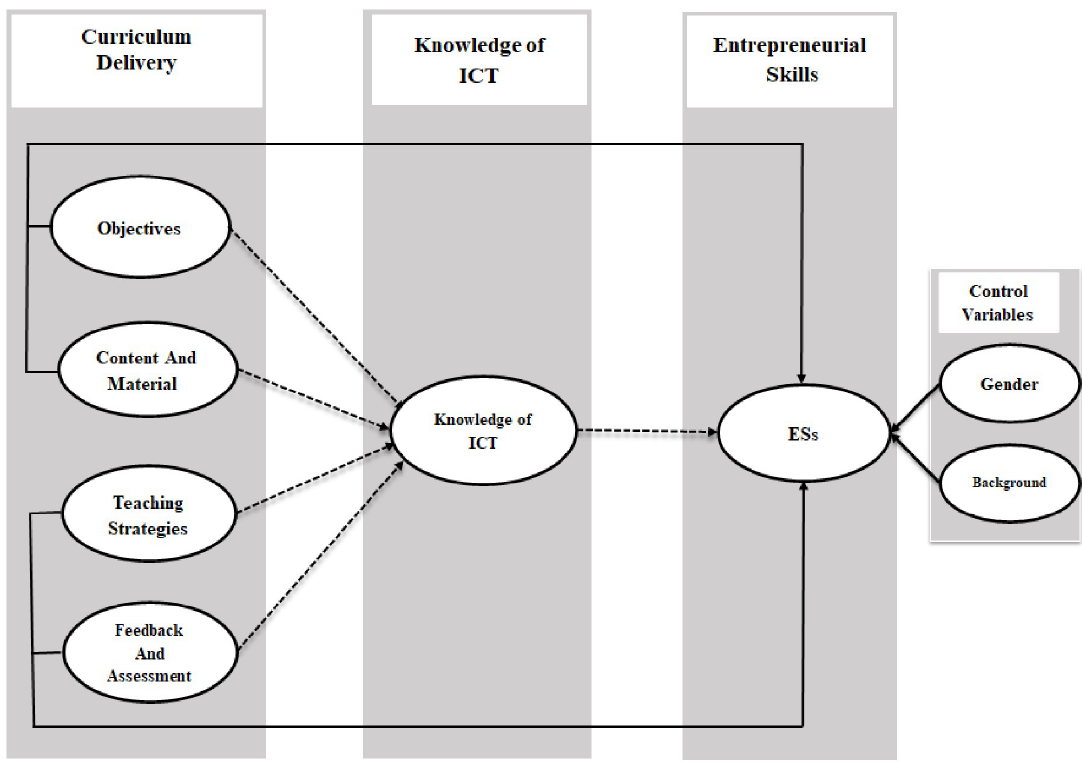
Fig 1. Research model. Solid and dashed arrows correspond to direct and indirect links, respectively, in the model.